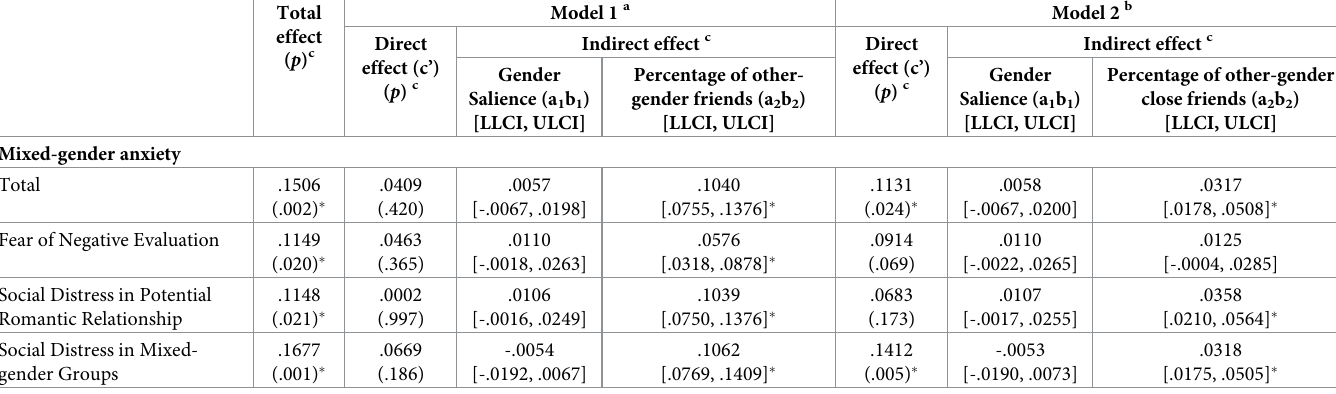
Table 5. Mediation results (Study 1: High school